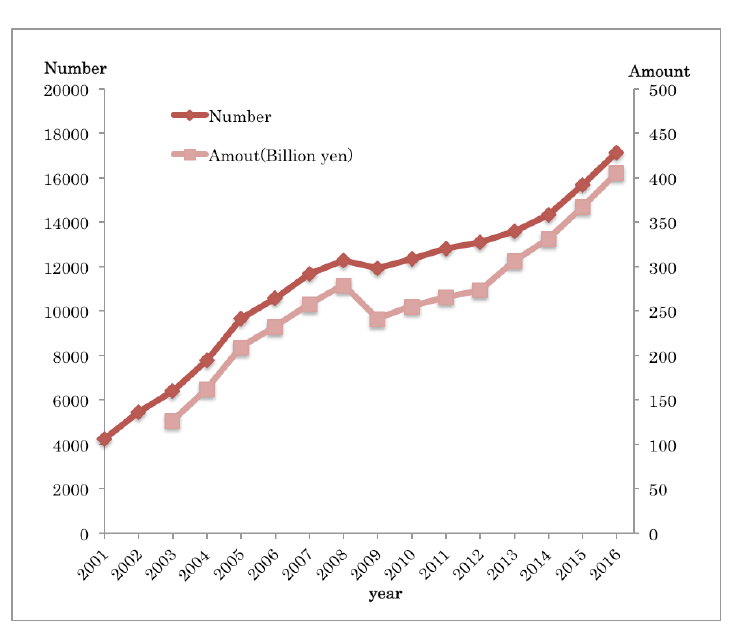
Figure 1. Collaborative research between national universities and private